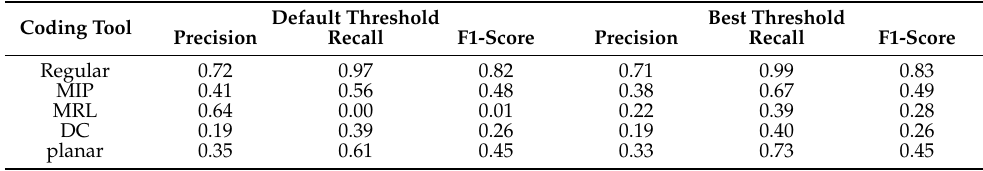
Table 2. Performance of the MTL CNN. Coding